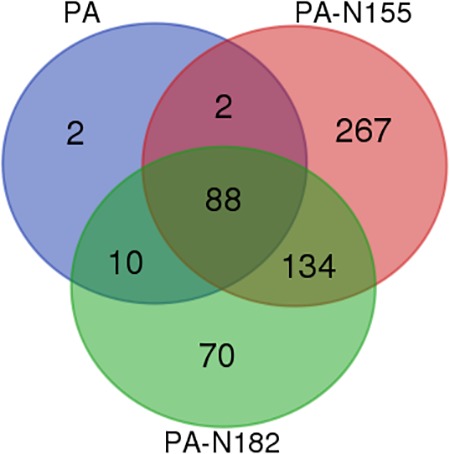
Difference between the interacting host proteins of PA, PA-N155, and PA-N182 of H5N1 IAV. Venn diagram showing shared host-interacting proteins between host factors associated with PA, PA-N155, and PA-N182. The host-interacting factors of PA-N155 and PA-N182 were identified in the present study. The PA-associated proteins were identified by Wang et al. (2016) in chicken cells.